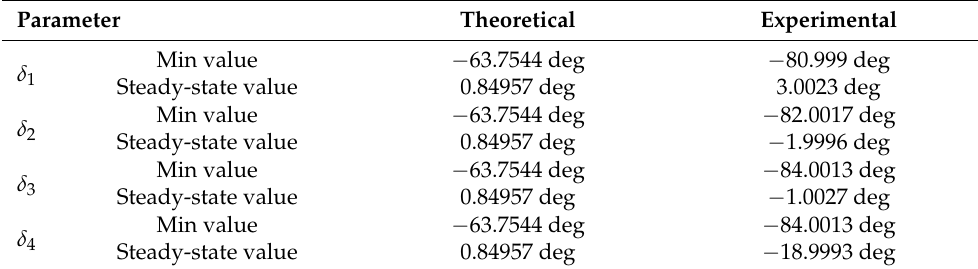
Table 7. Gimbal angle values for 180 deg maneuver.